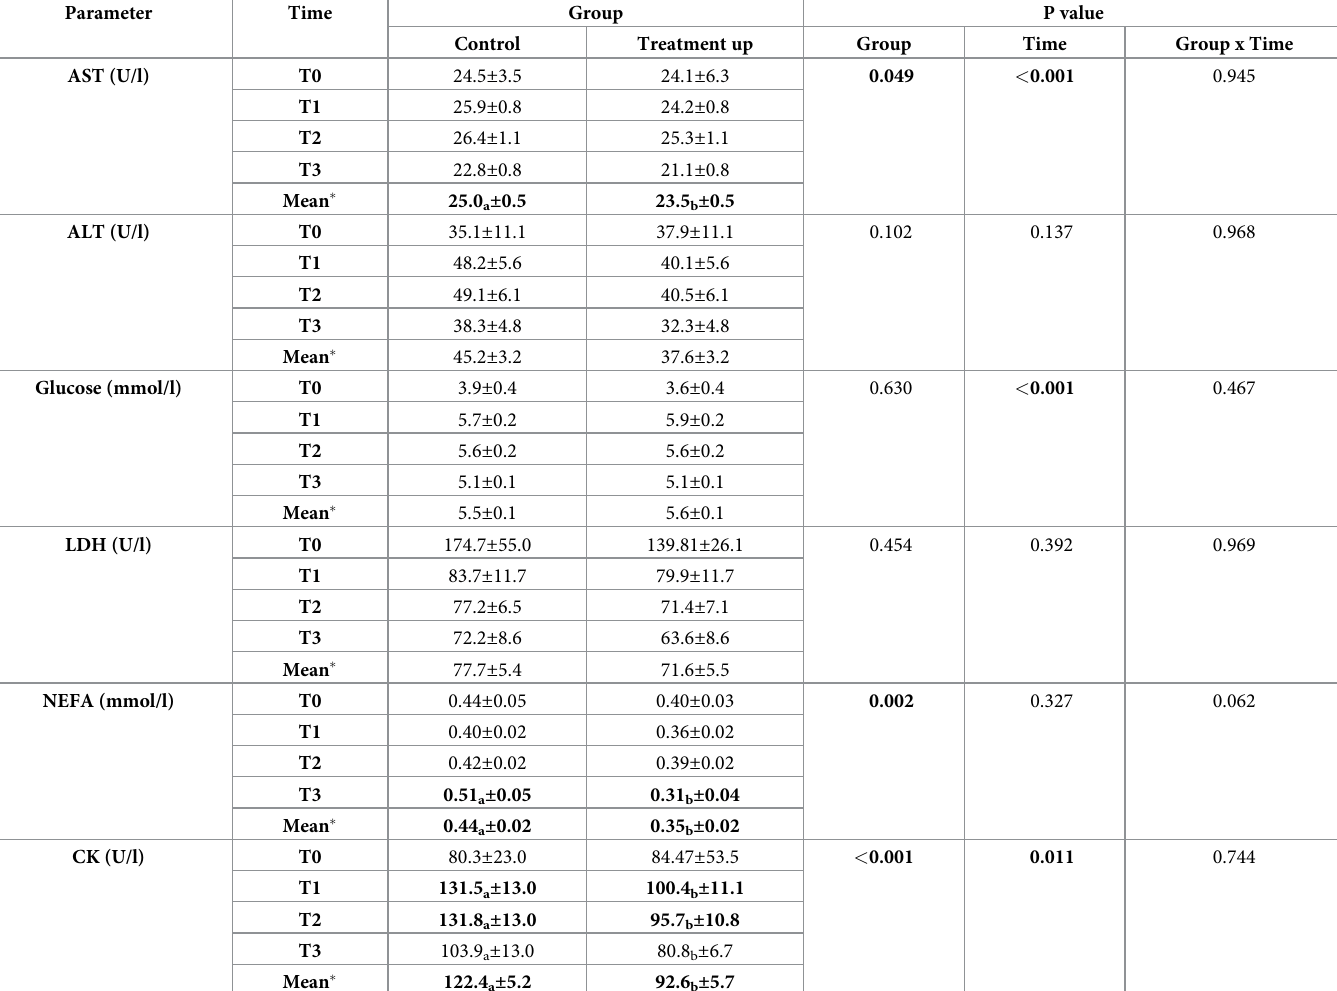
Table 2. Physiological parameters evaluated in control and treatment groups before starting nutritional supplementation (T0), before starting the treadmill exer- cise (T1), within 2 minutes after completing the treadmill exercise (T2) and after 30 min of passive recovery (T3). The values (raw data) are estimated means ± stan- dard error.